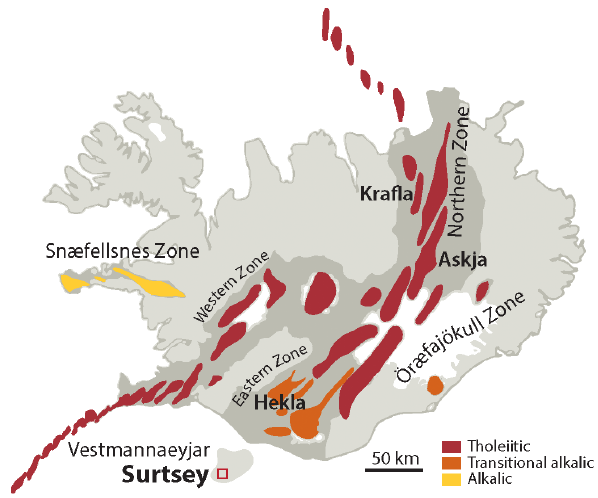
Figure 1. The location of Surtsey Volcano within the southernmost extension of the Eastern Icelandic rift zone (scale bar of 50km; af- ter Trønnes, 2002). Colors refer to compositional trends in basaltic rocks (Jakobsson et al., 2008).